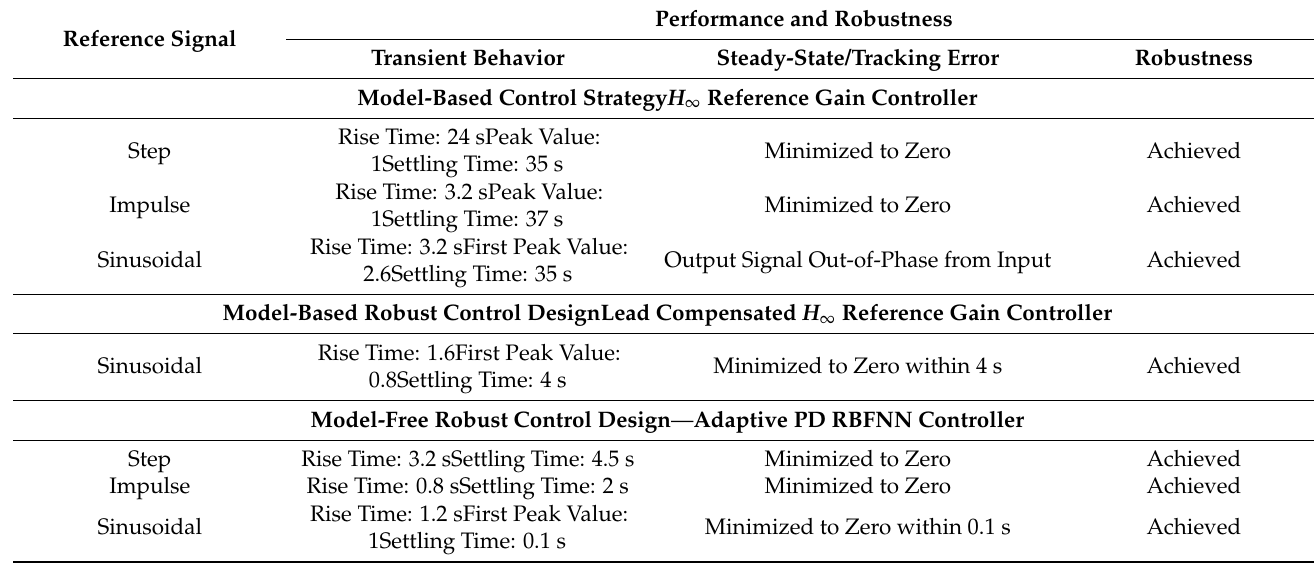
Table 2. Performance and Robustness-Displacement of Link_1 (Parallel to